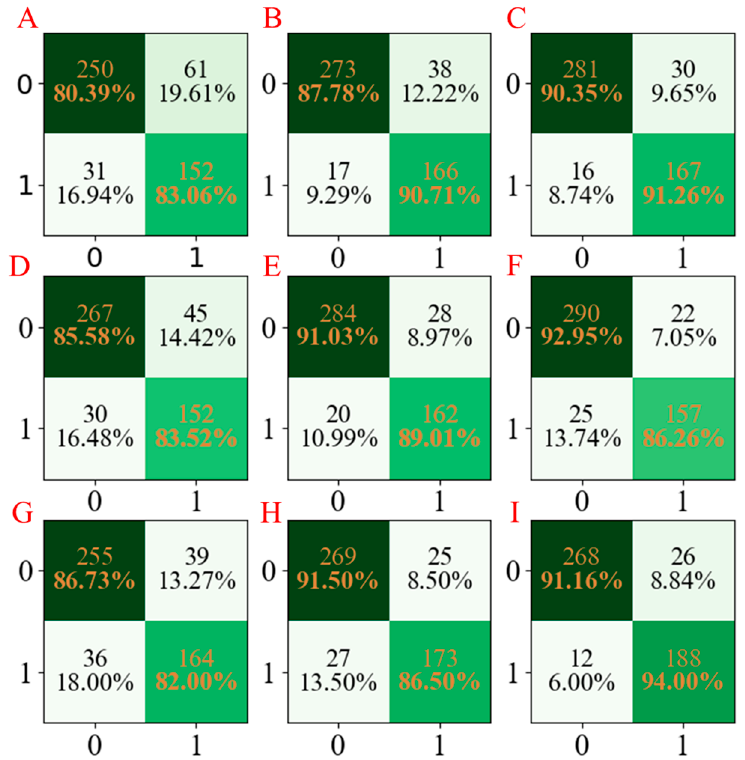
Figure 3. The confusion matrix of three models established for Caco-2 characteristics. The confusion matrix of the PLS-DA model using seed numbers 1234 ( A ), 5678 ( D ), and 1278 ( G ); the confusion matrix of the AdaBoost model using seed numbers 1234 ( B ), 5678 ( E ), and 1278 ( H ); the confusion matrix of the LGBM model using seed numbers 1234 ( C ), 5678 ( F ), and 1278 ( I ). Table 1. The precision, recall, and F1-score values of the established models for Caco-2 properties. Methods Seed Number Precision Recall F1-Score PLS-DA